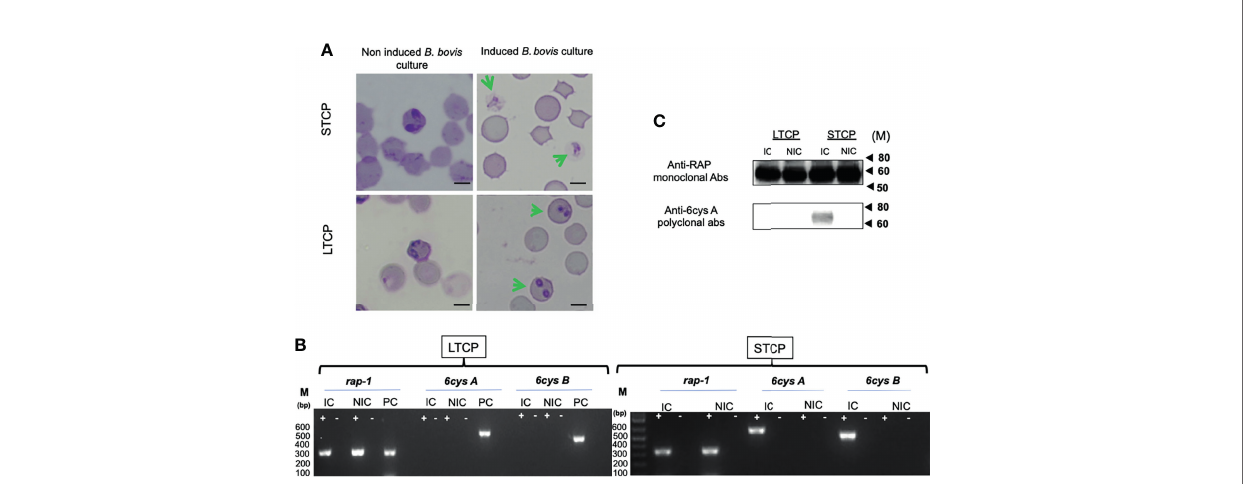
FIGURE 2 | Comparative analysis of LTCP vs STCP ability to develop sexual forms in an in vitro sexual Xa-induction system. (A) Parasite morphologies detected by light microscopy upon in vitro Xa-induction of sexual forms. Non induced cultures were used as a control for both strains. Bar 5 µm. (B) Comparative RT-PCR analysis for the detection of transcripts of sexual stage maker genes, 6cys A and 6cys B between LTCP and STCP. Transcripts derived from the rap-1 gene were used as a positive control. RNA extracts were derived from (NIC) non-induced and (IC) induced in vitro cultures. M represents the sizes of molecular markers in base pairs. PC: Genomic positive control. (C) Western blot analysis for detection of 6cys A protein expression as a sexual stage marker using non-induced (NIC) and induced (IC) in vitro cultures of LTCP and STCP. The monoclonal antibody BABB75, reactive with B . bovis RAP-1, was used as a positive control. M represents the sizes of molecular markers in kiloDaltons (kD). The ampli fi cations were performed without the addition of reverse transcriptase (-) and on cDNA generated from total RNA extracted from B . bovis infected RBCs